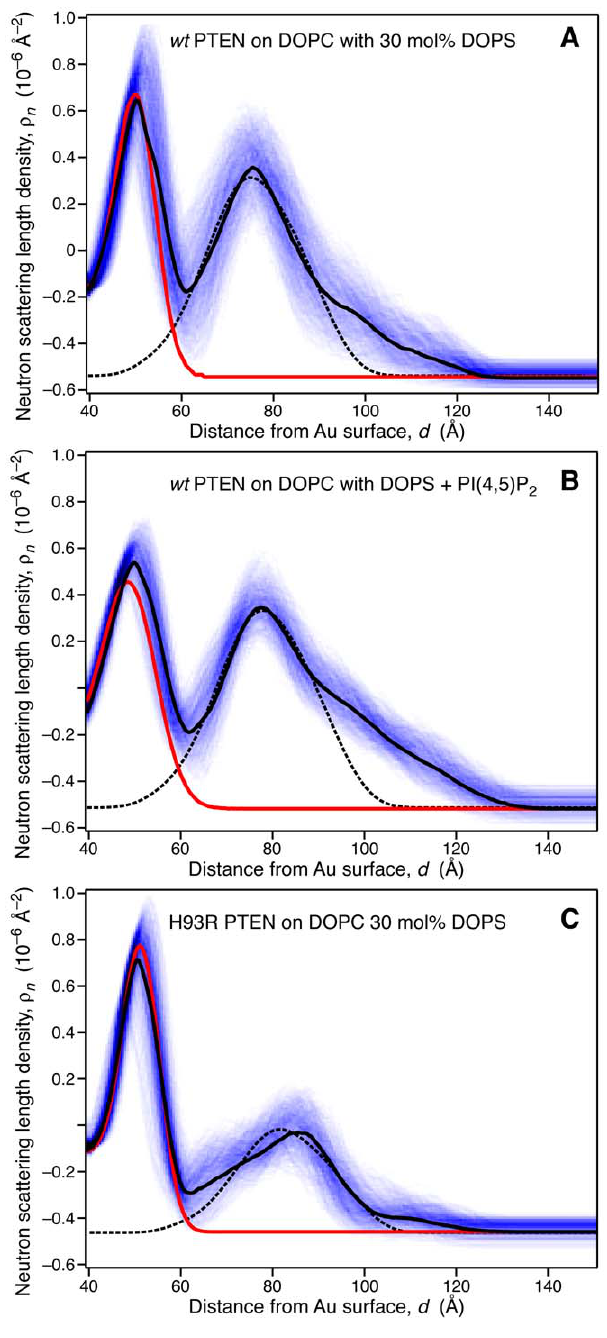
Figure 4. Comparison of nSLD profiles of PTEN Interfacially Bound to Lipid Bilayers and Their Correspondence with the Crystal Structure of the Truncated PTEN. The protein contribu- tions ( d =60–120 A˚ from the Au surface) to the overall nSLD profile correspond to wt PTEN adsorbed to stBLMs (A) with 30 mol% DOPS ( + chol), (B) with 28.6 mol% DOPS and 2.6 mol% PI(4,5)P 2 ( + chol), and to H93R PTEN adsorbed to an stBLM with 30 mol% DOPS ( + chol). The peak near d =50 A˚ originates from the lipid headgroups. The color coding is the same as in Fig. 3, and panel (A) is a close-up view of the results shown there. Dashes black lines represent the best-fit overlay of a scaled nSLD distribution calculated from the crystal structure of the truncated PTEN variant. Because different amounts of protein was adsorbed in the individual experiments, the ratios between the protein and lipid headgroup peaks varies from sample to sample.